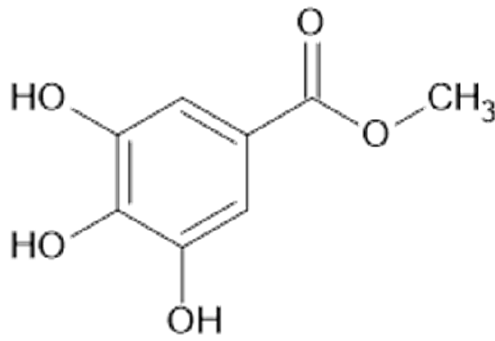
Figure 12. Chemical structure of compound 65 (MW = 184).